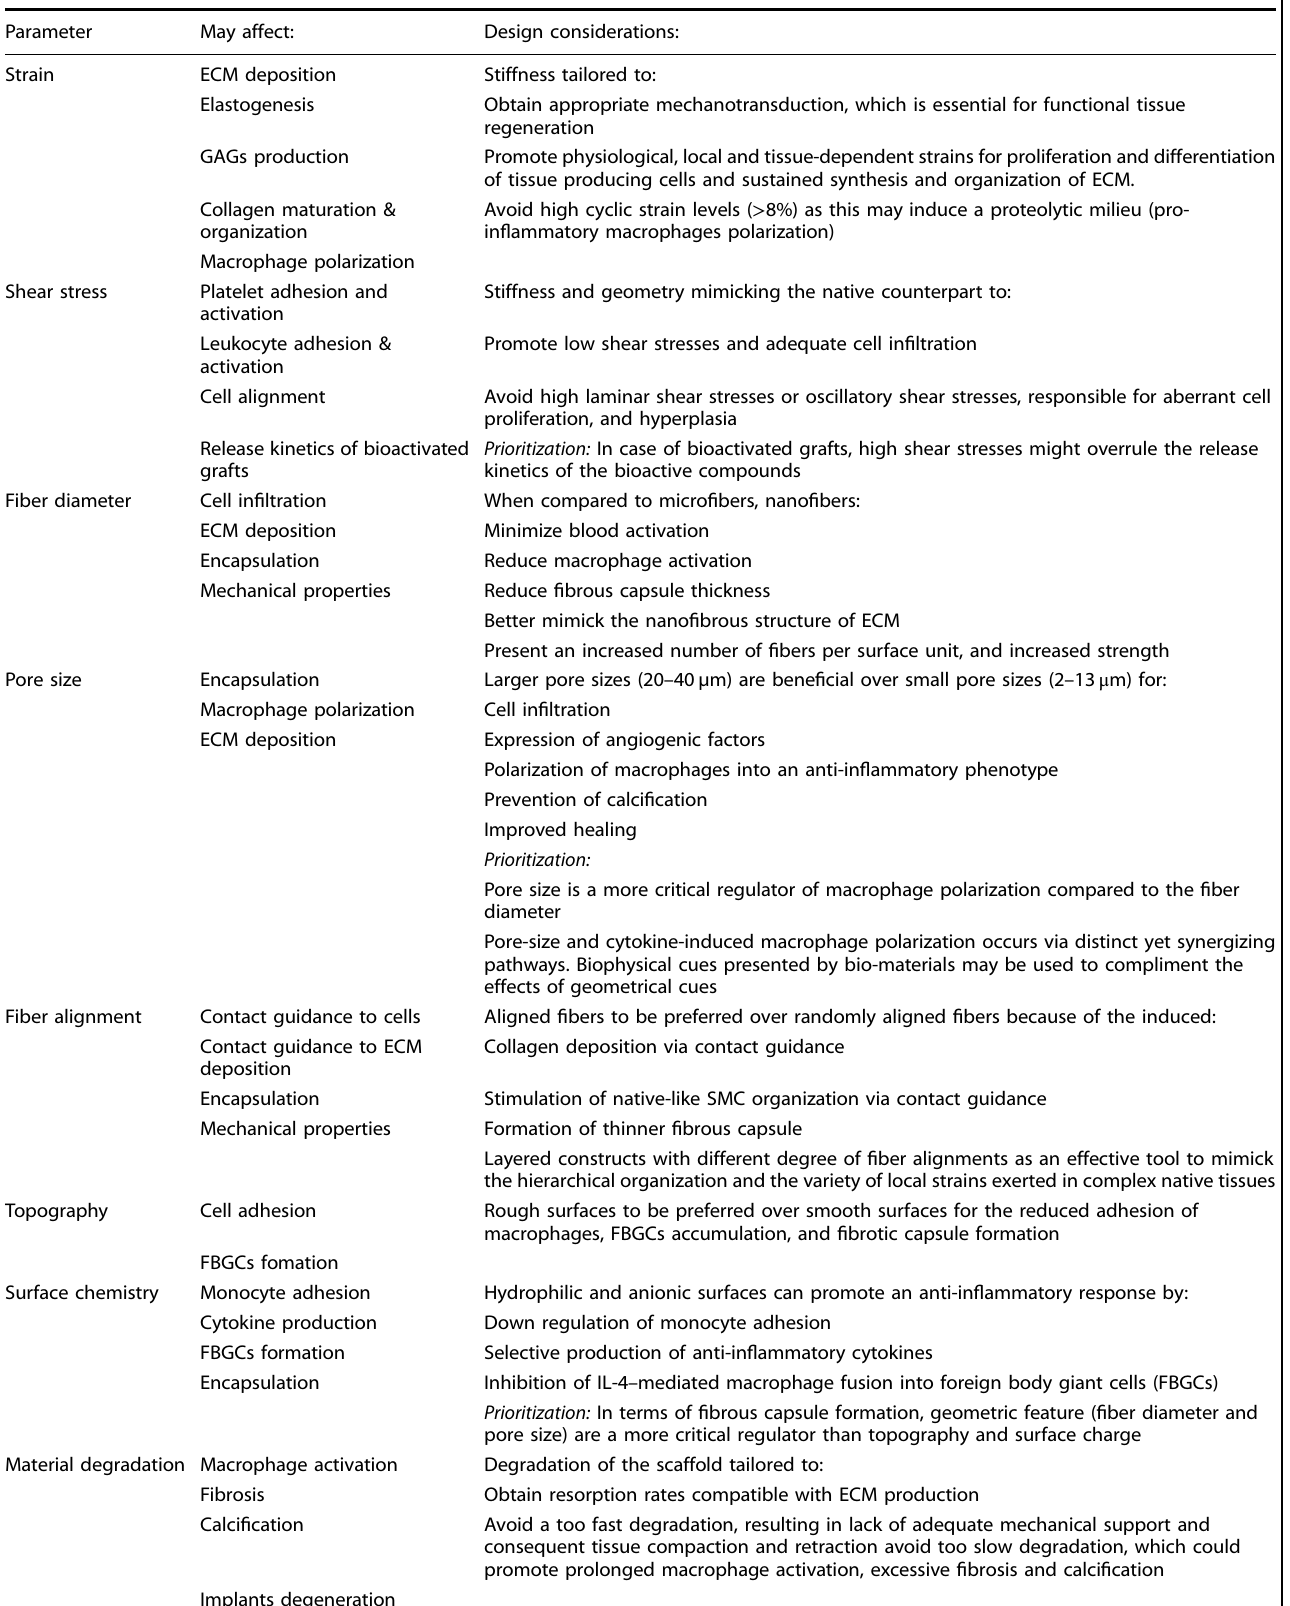
Table 3. Suggested scaffold design principles regarding physical and biomechanical microenvironment Parameter May